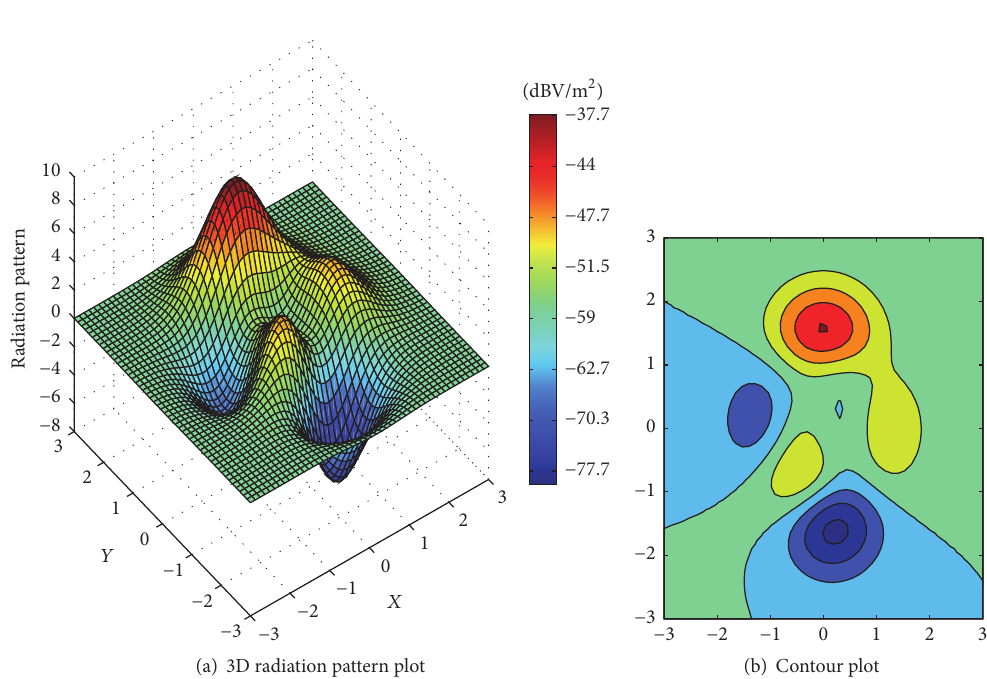
Figure 7: Optimized radiation pattern at centre frequency 5.8